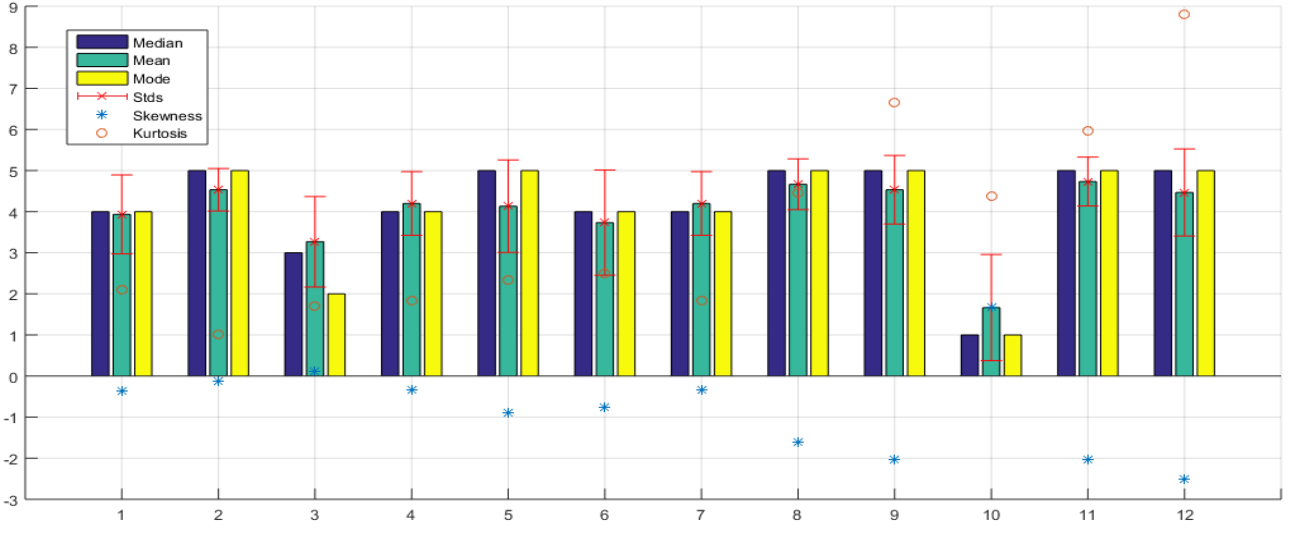
Figure 22. Usability and user experience evaluation